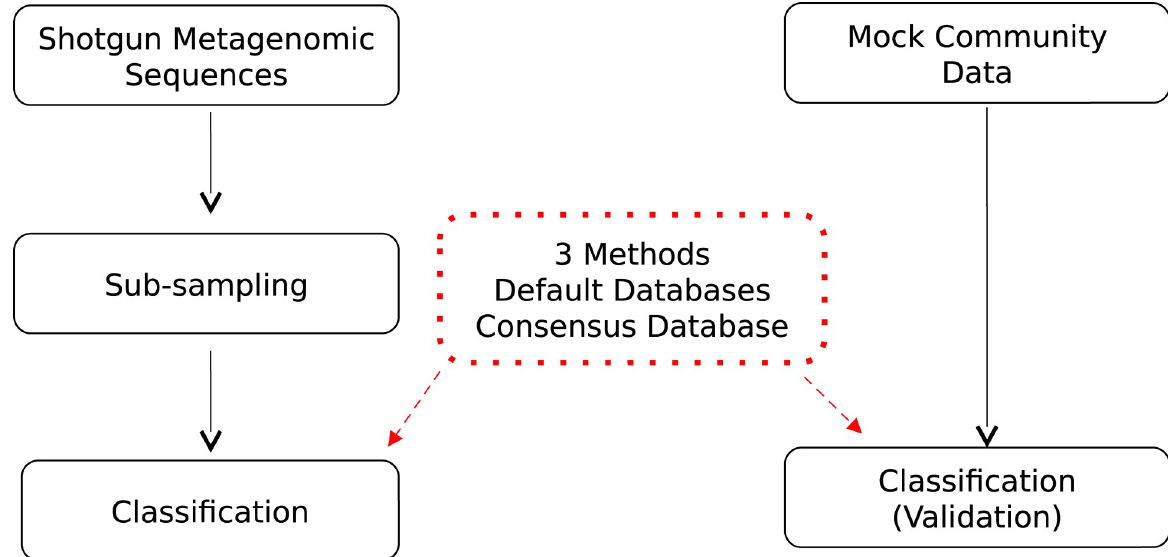
Fig 1. General workflow. Next generation shotgun deep sequences were subsampled to simulate varying sequencing depths. Methods used in this study were validated using mock community data, and subsampled sequences were taxonomically classified using different databases. end, around 200 million reads). Subsampling scripts are available at https://git.oru.se/srrn/